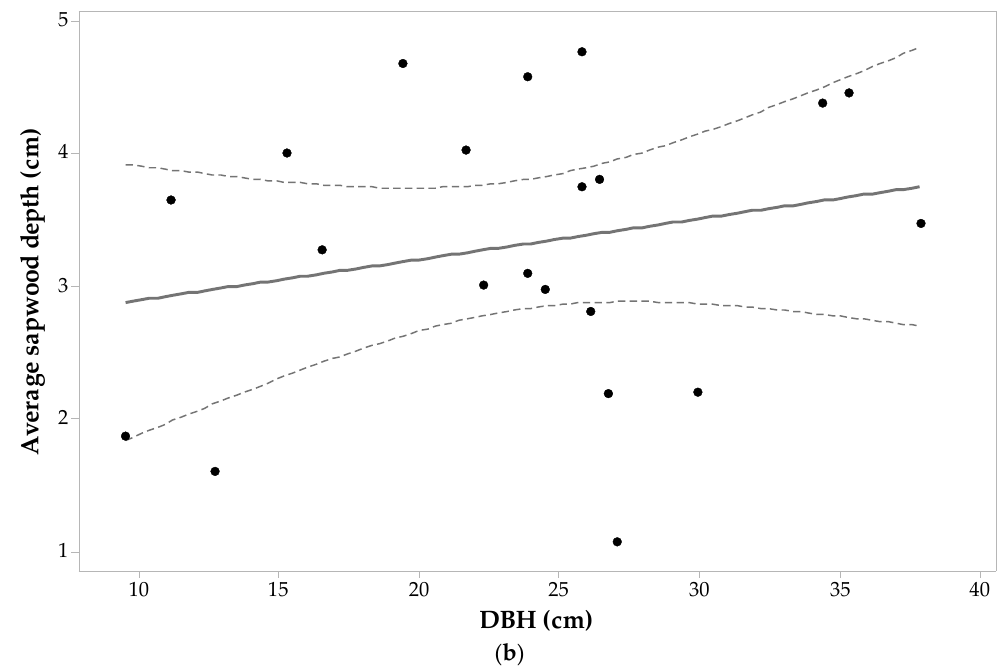
Figure 7. Picea mariana ( a ) sapwood depth (cm) at each cardinal point for each tree versus DBH ; and ( b ) average sapwood depth (points) with 95% confidence intervals (dashed lines) and a fitted linear regression model (solid line). Three values are missing on sd W and one on sd E . Two values were not estimated due to wood decay and one sd W was an outlier ( DBH = 15.28 cm)